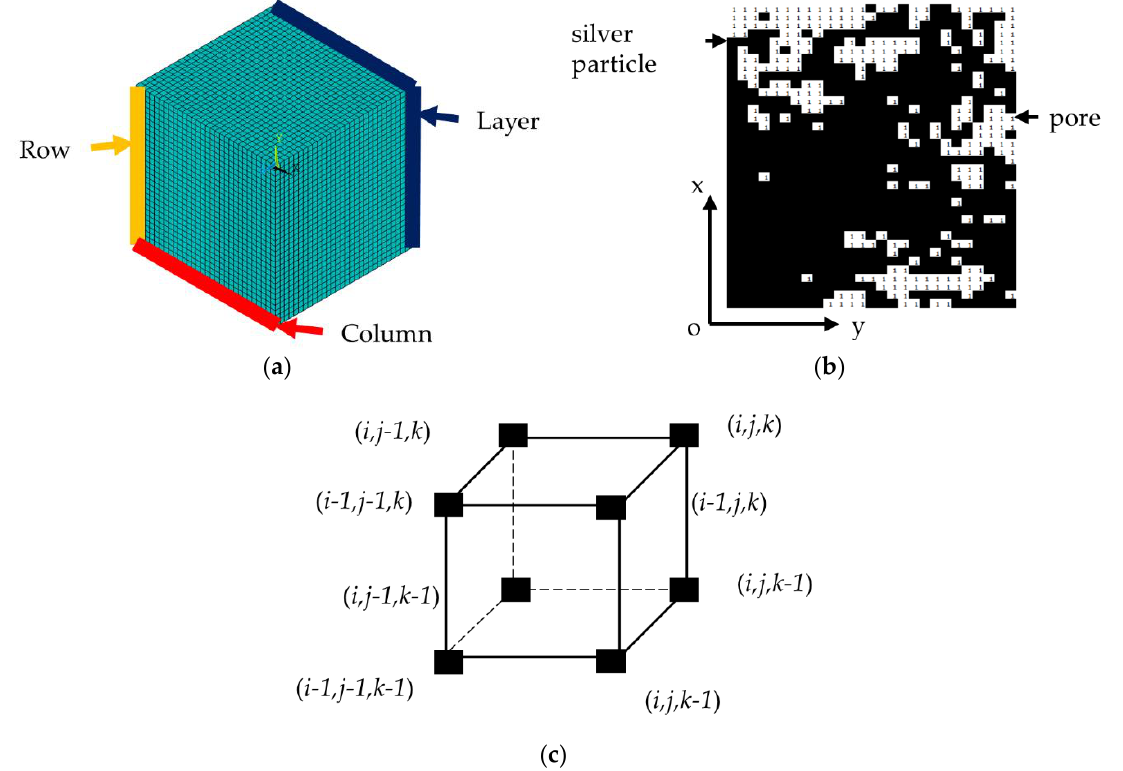
Figure 7. Indication of spatial data. ( a ) Spatial volume data; ( b ) A thin-layer model; ( c ) One voxel built in ANSYS Mechanical.